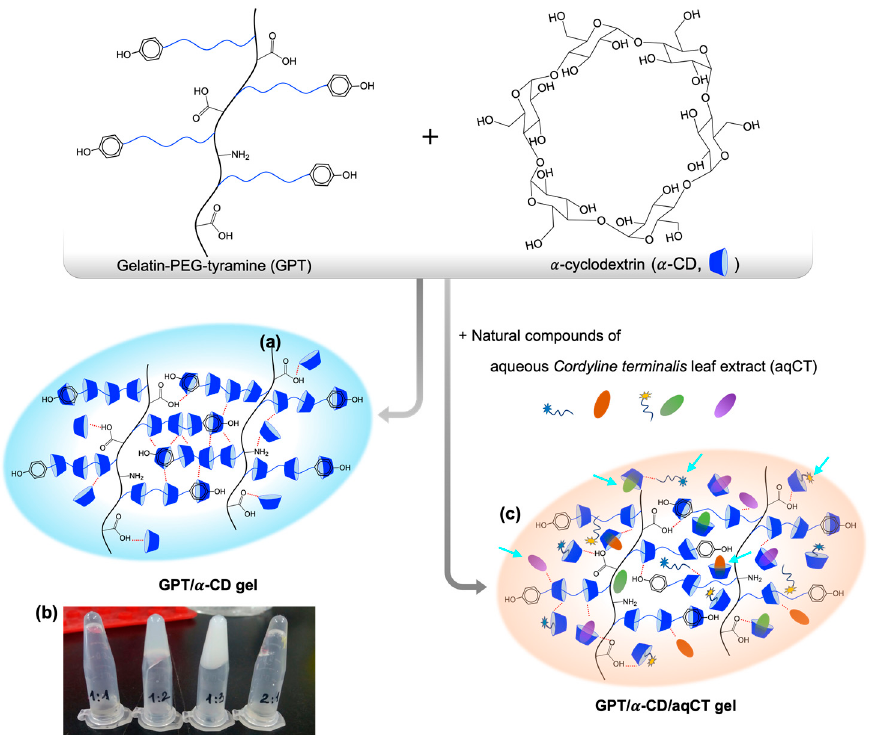
Figure 1. Schematic illustration of the gel formation: gelatin–polyethylene glycol (PEG)–tyramine (GPT) and α -cyclodextrin ( α -CD) were mixed together to fabricate GPT/ α -CD gel ( a ). Different GPT/ α -CD ratios of 1:1, 1:2, 1:3, and 2:1 were tested, and only two formulas of 1:2 and 1:3 were gelled ( b ). The GPT/ α -CD/aqCT gel was fabricated from GPT/ α -CD gel encapsulating aqueous Cordyline terminalis leaf extract (aqCT) containing various natural compounds, including alkaloids, cardiac glycosides, saponins, and phenolic compounds ( c ). Table 2. Gelation time of various hydrogel